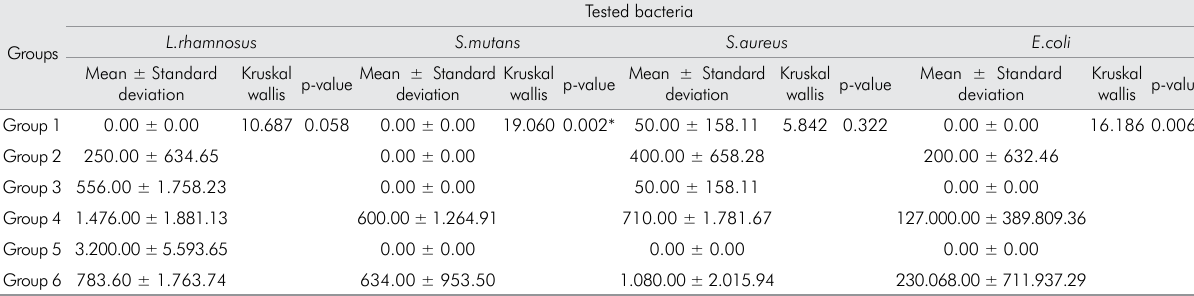
Table 2. The results of Kruskal Wallis test according to each bacteria.